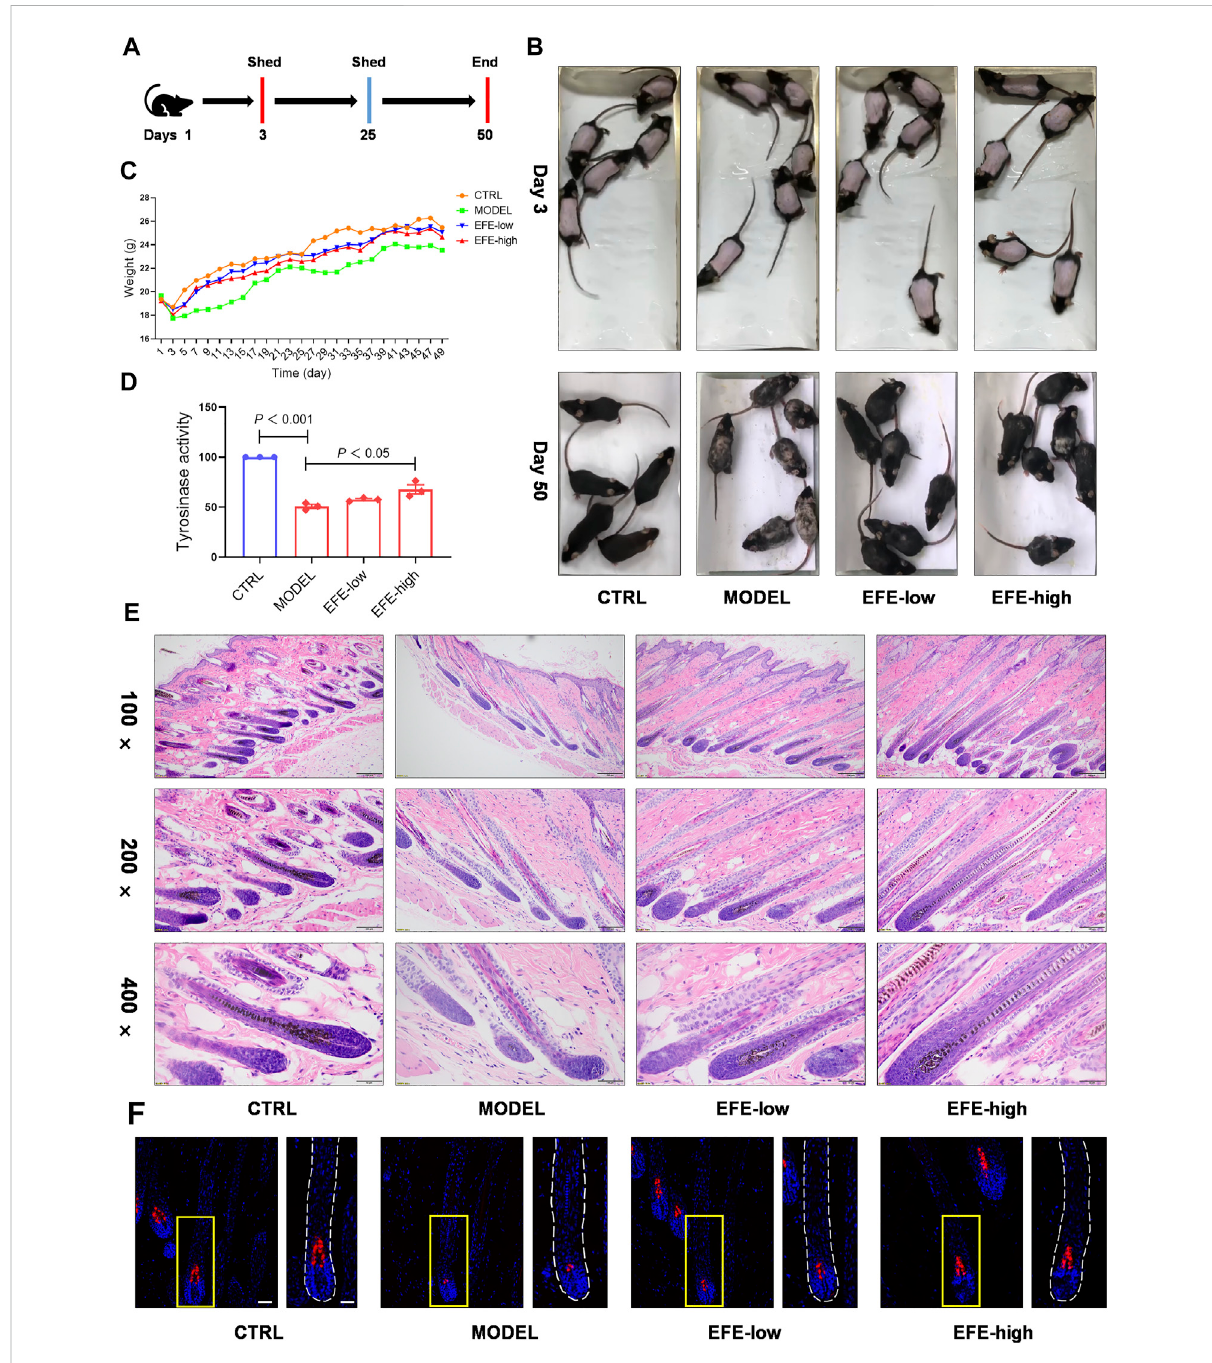
FIGURE 4 EFE causes pigment-darkening effects in human primary melanocyte, human skin-organ culture, perilesional tissue, and depigmented models ofzebra fi shandC57BL/6micebyactivatingtyrosinase. (A) Timelineofmiceexperimentprocedure; (B) imagesofC57BL/6micedorsalhaircolor; (C) statistic for mice bodyweight; (D) tyrosinase activity of mice dorsal skin; (E) representative images of hematoxylin eosin staining of the mice hair follicle (100 ×: scale bar = 200 μ m, 200 ×: scale bar = 100 μ m, 400 ×: scale bar = 50 μ m); (F) representative images of immuno fl uorescence staining of hair follicles (200 ×: scale bar = 100 μ m, 400 ×: scale bar = 50 μ m). For graphical representation, data are presented as mean ± SEM ( n ≥ 3 in each group), p < 0.05, p < 0.01, p < 0.001 vs. CTRL are considered signi fi cant. Representative image from three independent experiments is